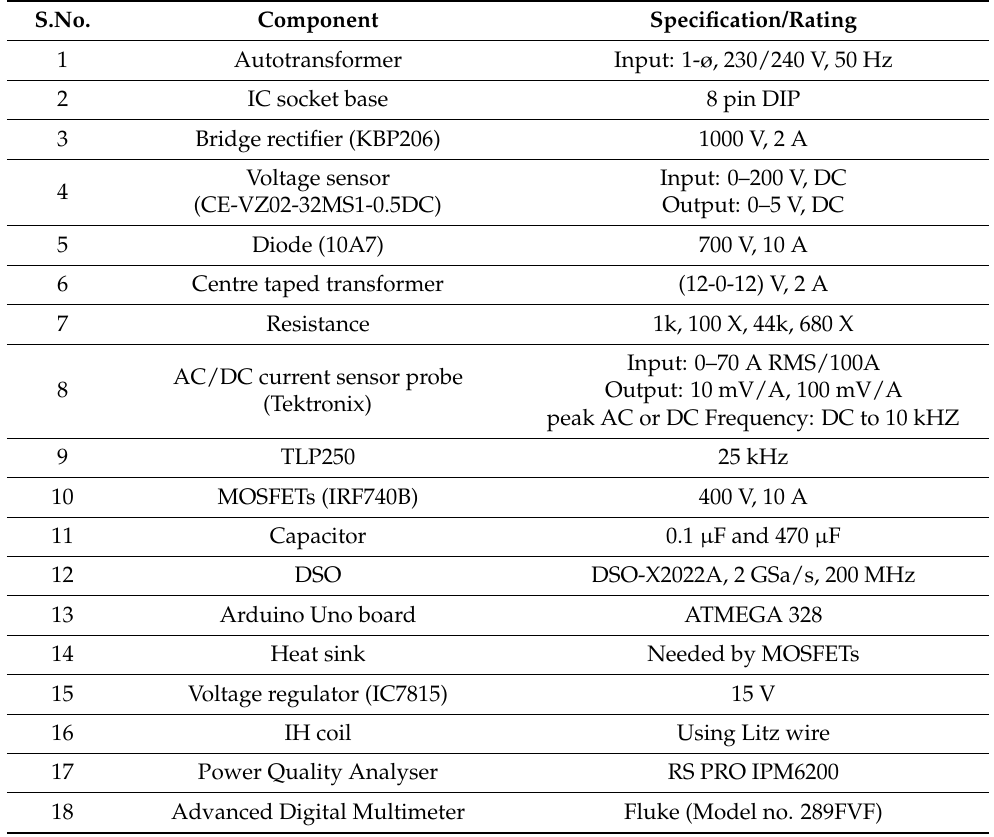
Table A1. Components for the implementation of prototype of the proposed system.